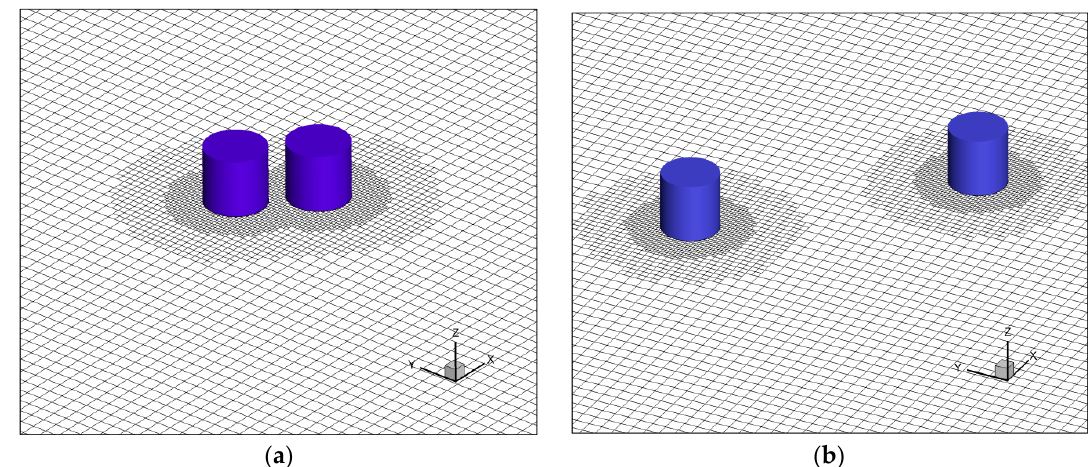
Figure 3. Computational grids around two cylinders with an alignment angle of 45 ° : ( a ) s / D = 1.25; ( b ) s / D = 5.0.